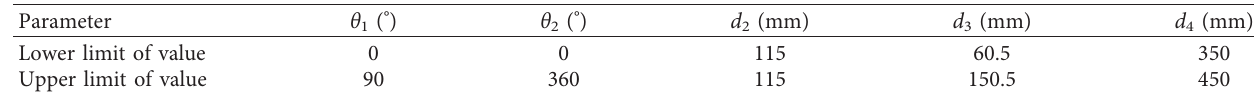
Table 2: The value range of D-H